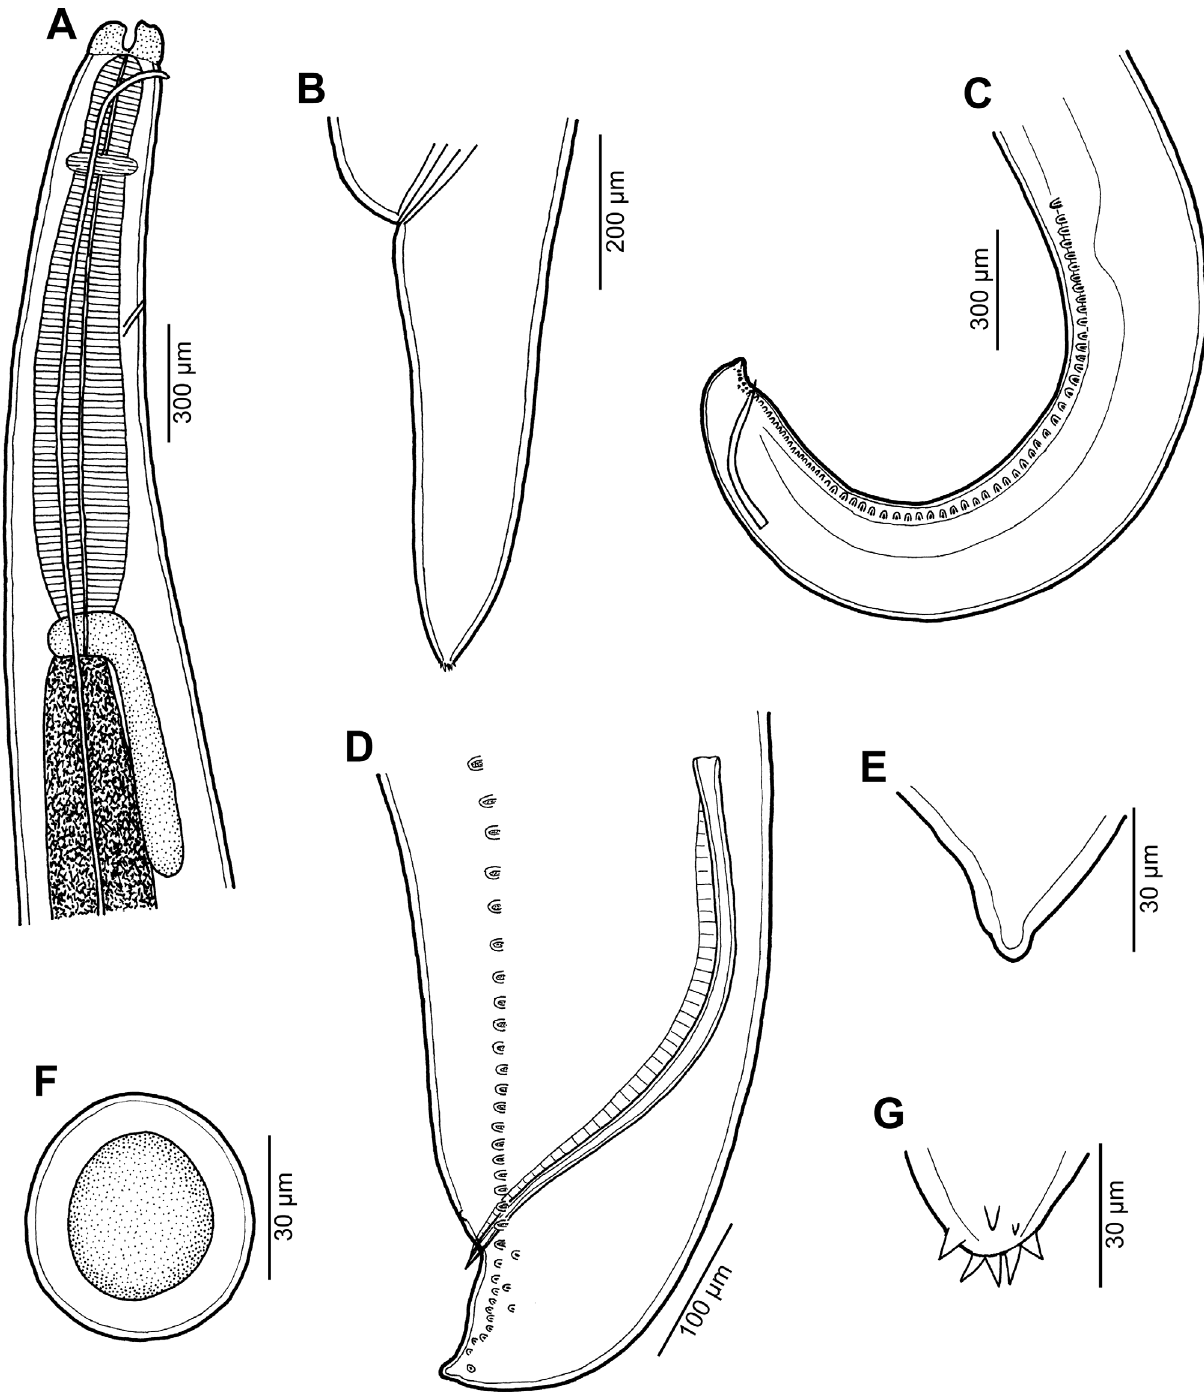
Figure 3. Raphidascaris ( Ichthyascaris ) fasciati n. sp. ex Epinephelus fasciatus . (A) Anterior end of male, lateral view; (B) tail of gravid female, lateral view; (C) posterior end of male, lateral view; (D) caudal end of male, lateral view; (E) tail tip of male; (F) egg; (G) tail tip of